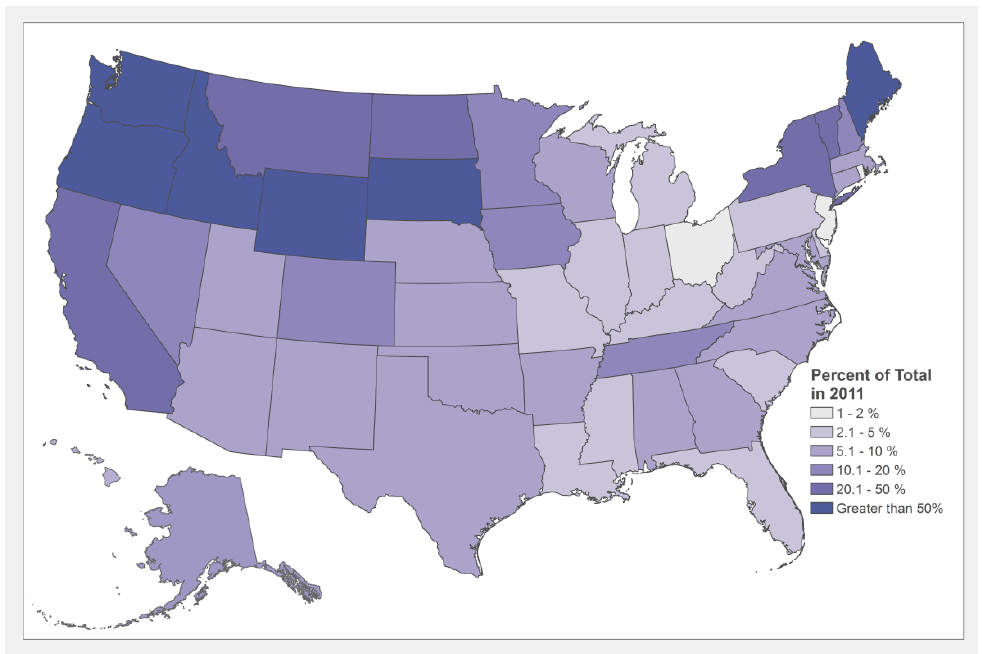
Figure 7. Percent of all electricity production from renewable sources, 2011. Renewable energy sources included: conventional hydroelectric, geothermal, wood and wood derived fuels, other biomass, wind, solar thermal and photovoltaic. Categories classified and data provided by US EIA